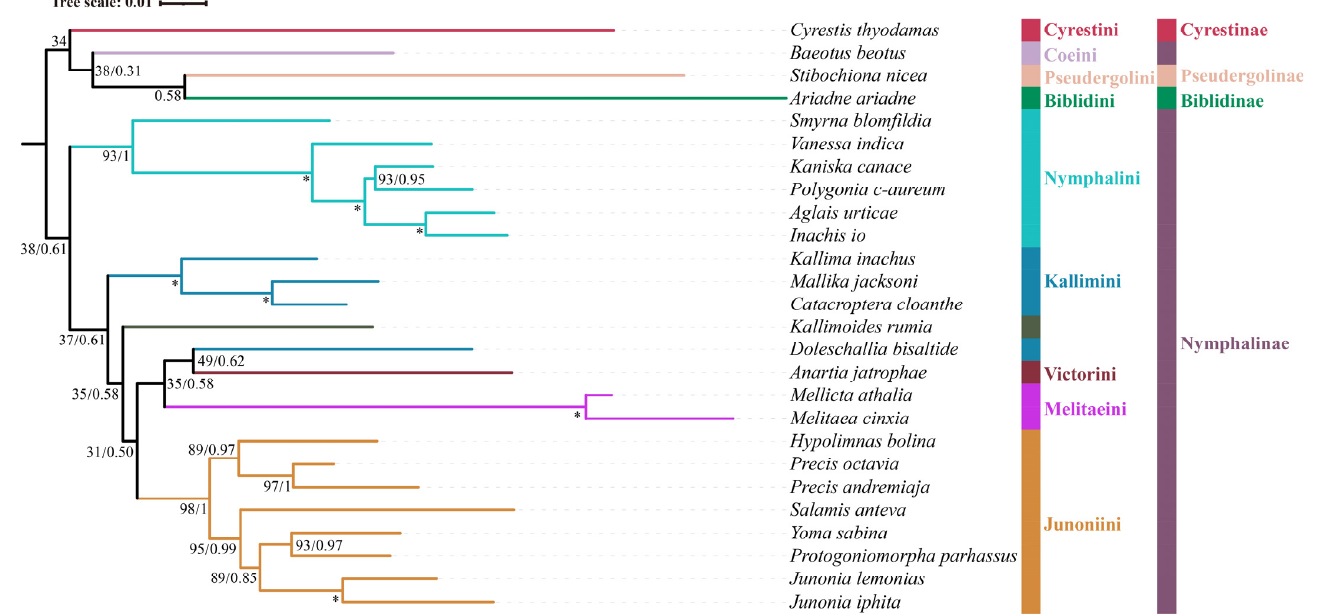
Figure 2. Phylogenetic analysis using the ML and BI methods based on the nDNA dataset. Bootstrap support (BS) values and posterior probability (BPP) are indicated at nodes (from left to right). Maximum support values produced are indicated by star symbols.